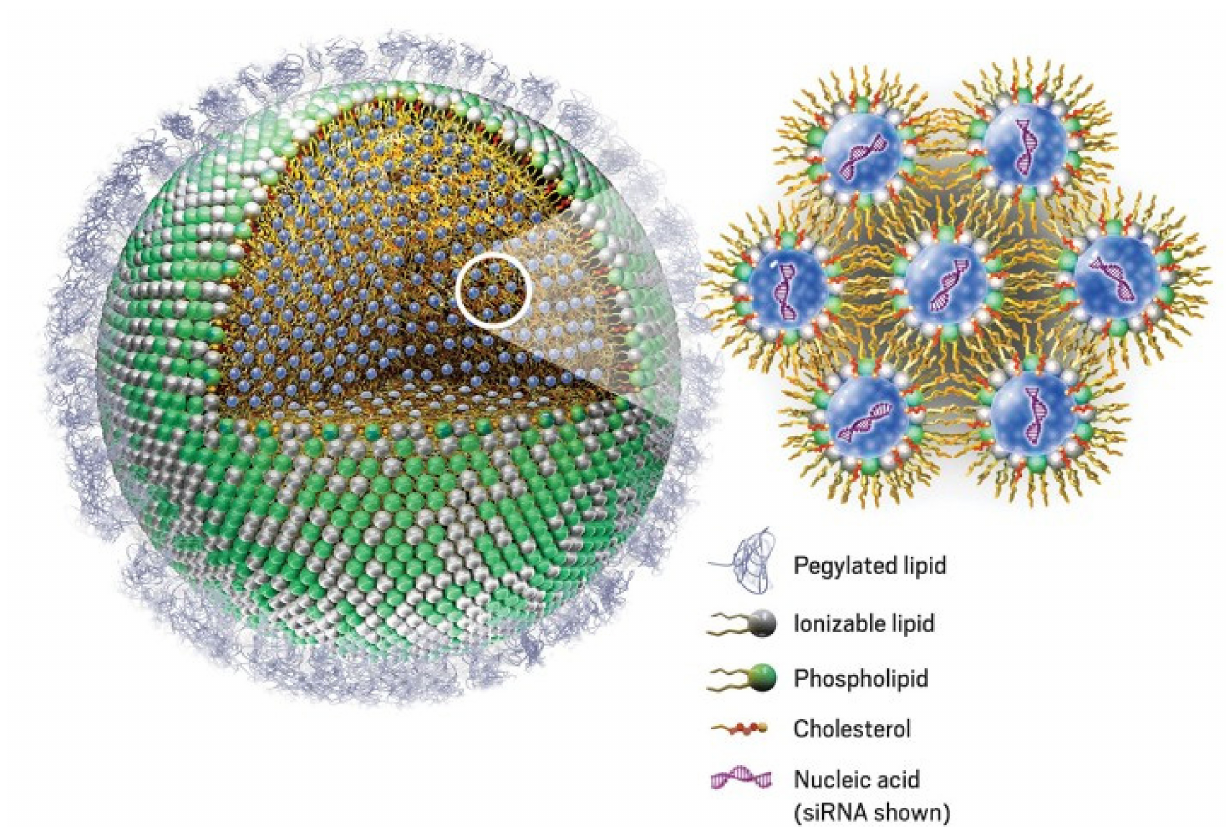
(siRNA) molecules, each surrounded by ionizable lipids, phospholipids, and